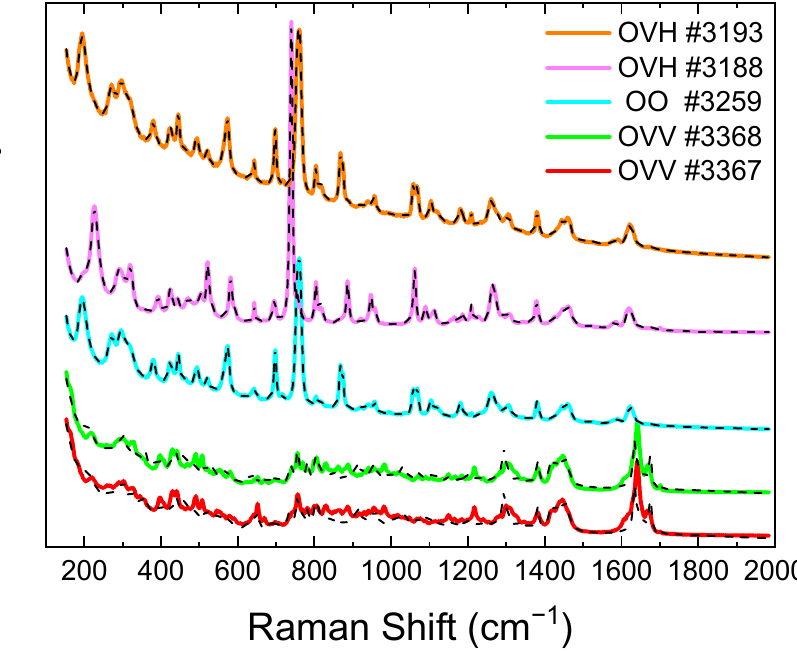
Figure 3. The Raman spectra of the investigated Origanum essential oils originating from plants identified as Origanum vulgare subsp . vulgare (OVV, #3367 and #3368), Origanum onites (OO, #3259) and Origanum vulgare subsp . hirtum (OVH, samples #3188 and #3193). The obtained multiple linear regression fitting curves (dashed lines) are also illustrated.